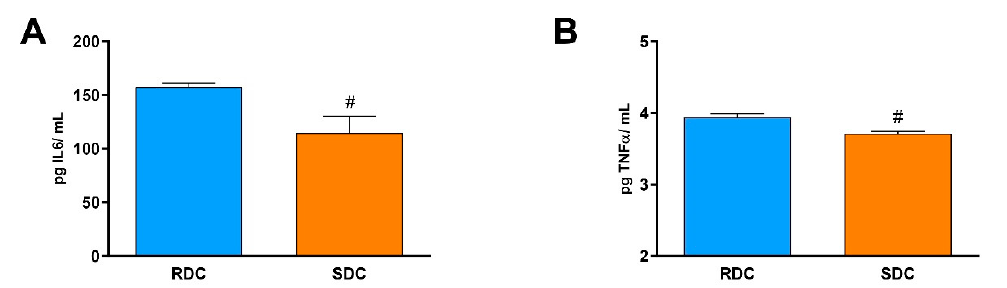
Figure 11. Inflammatory biomarkers in the RDC and SDC groups. Serum interleukin 6 (IL-6) ( A ) and tumor necrosis factor α (TNF- α ) ( B ) levels have been determined for the RDC and SDC groups. RDC group, refeeding with rapid digestible CHO diet; SDC group, refeeding with slow digestible CHO diet. # Significant difference with RDC group, p < 0.05.